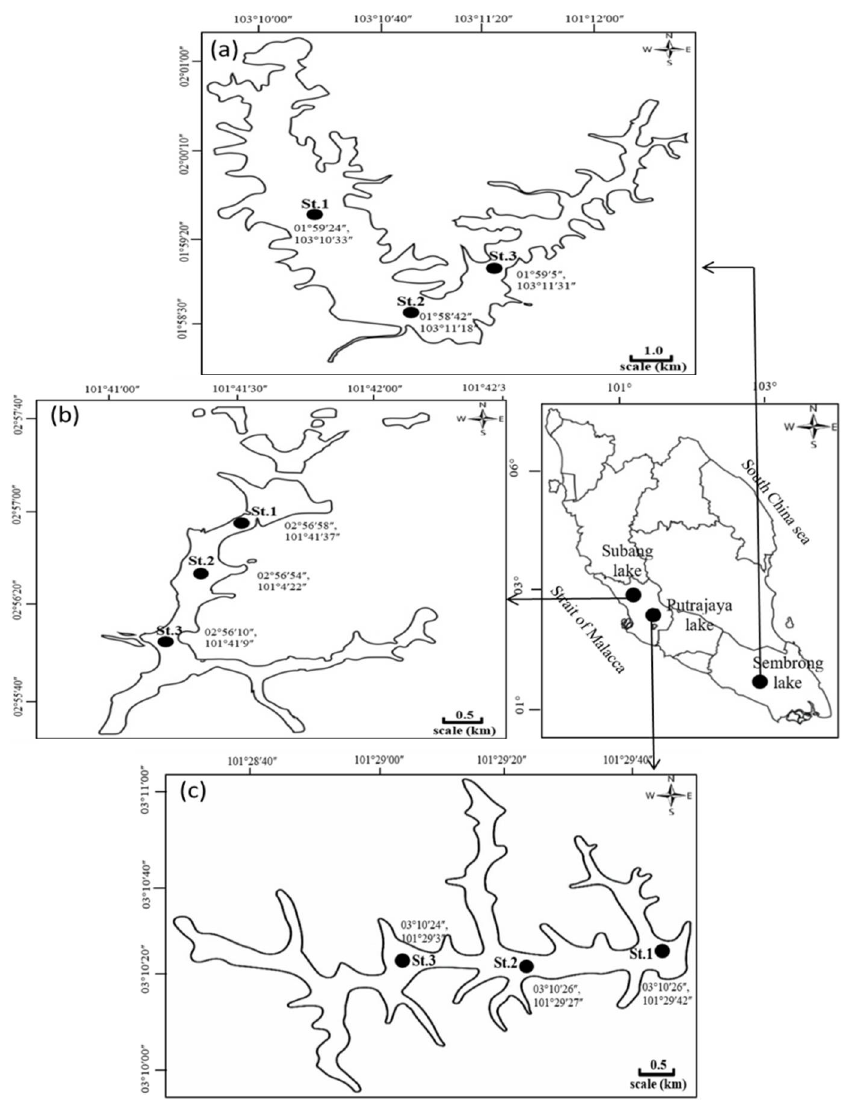
Figure 1. Map of Peninsular Malaysia and location of sampling stations in each lake ( a ) Sembrong, ( b ) Putrajaya and ( c ) Subang lakes.